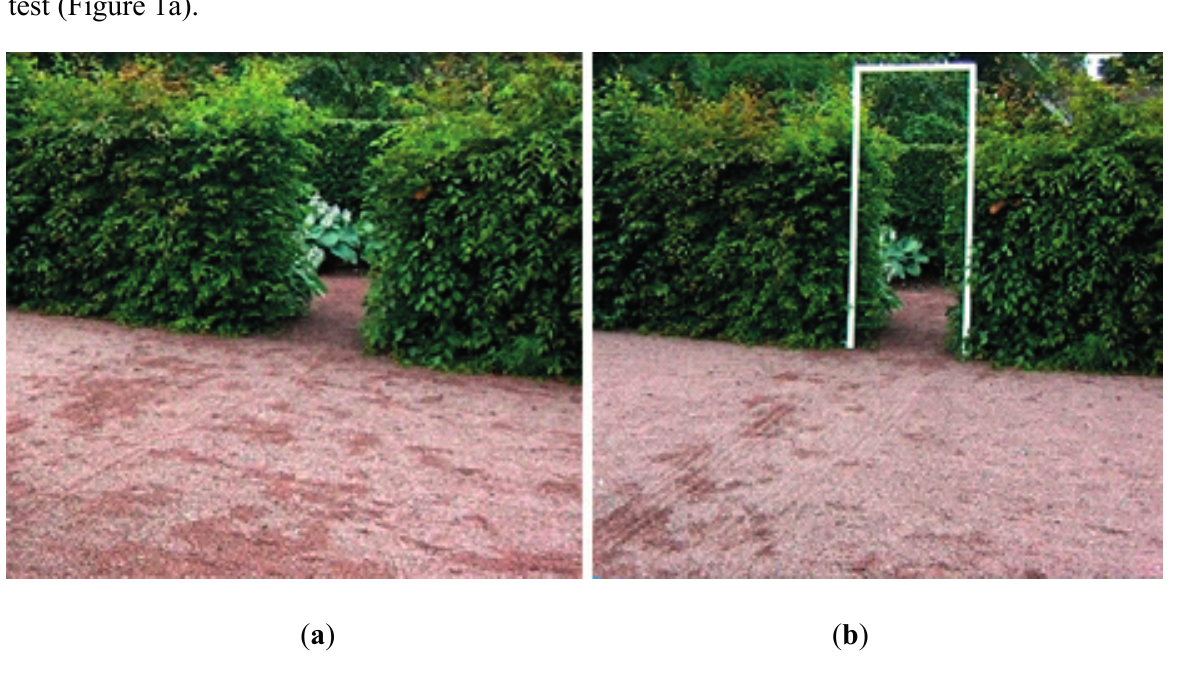
Figure 1. ( a ) Passageway through only the hedge opening; ( b ) and through the hedge opening with the white